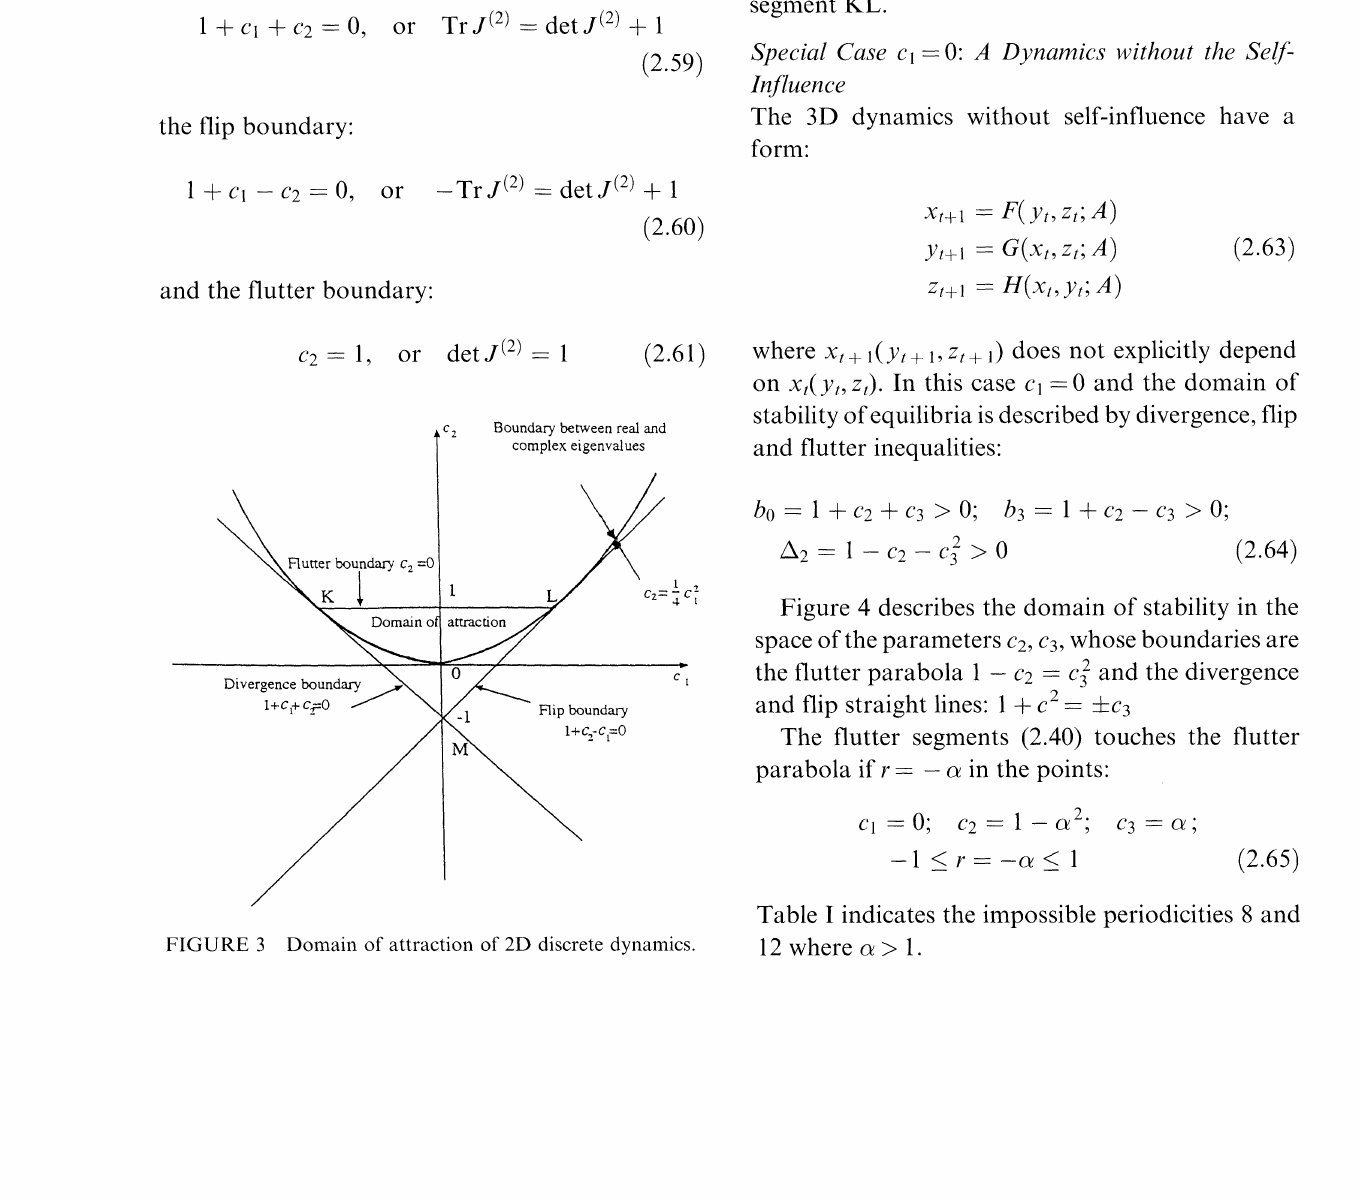
FIGURE 3 Domain of attraction of 2D discrete